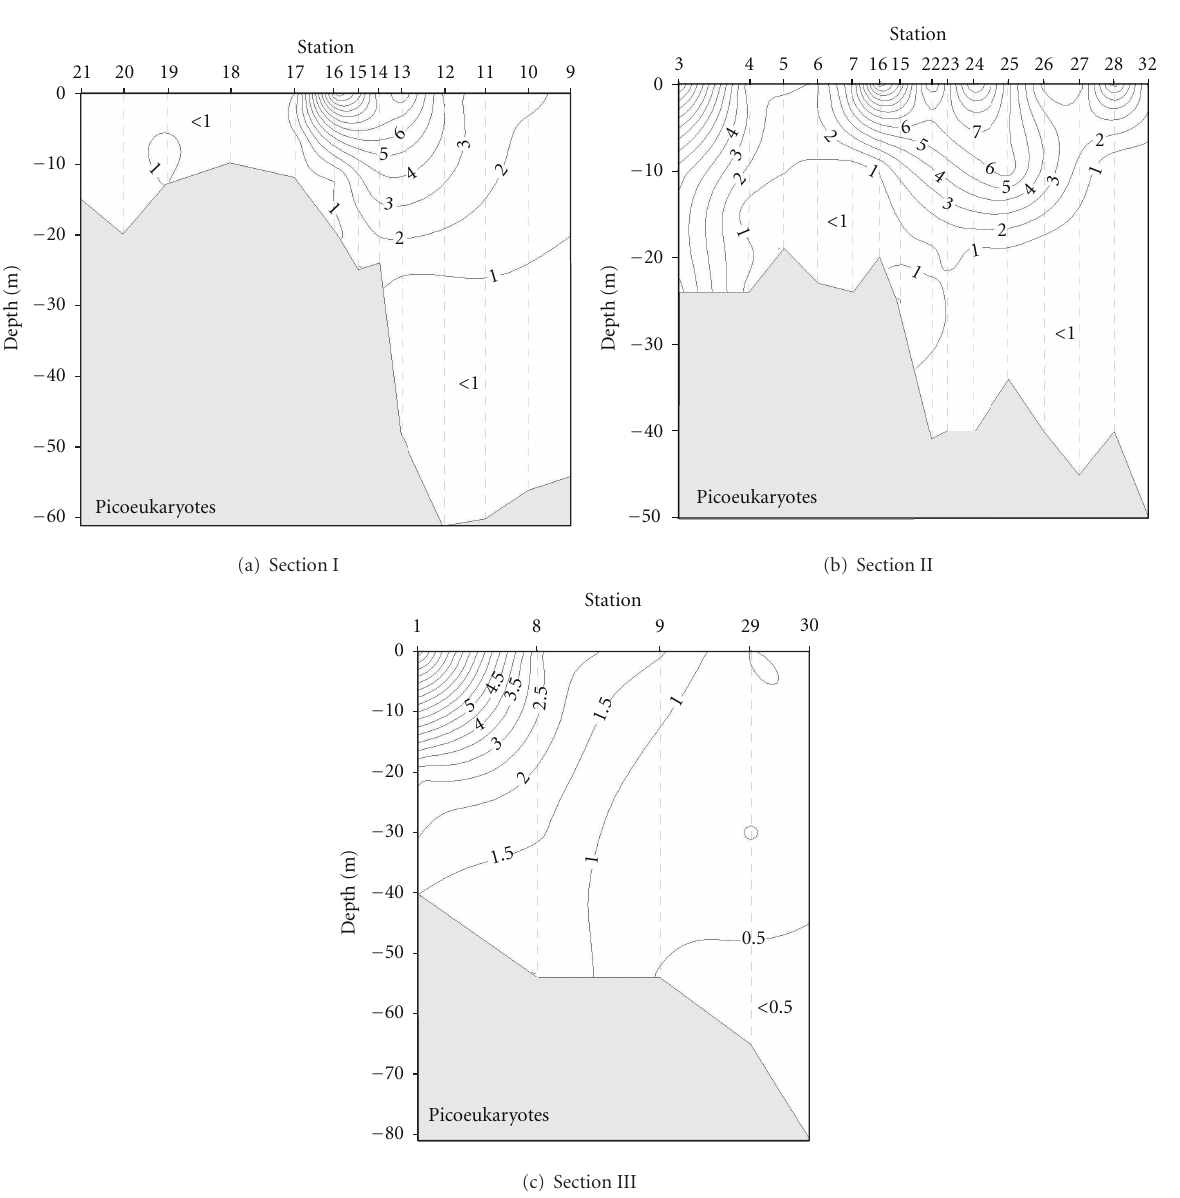
80 ◦ C before FCM analysis [15, 24]. Bacteria and viruses were characterized according to their distinctive side scatter and green fluorescence signals, which are related to their size and nucleic acid content, respectively [15,